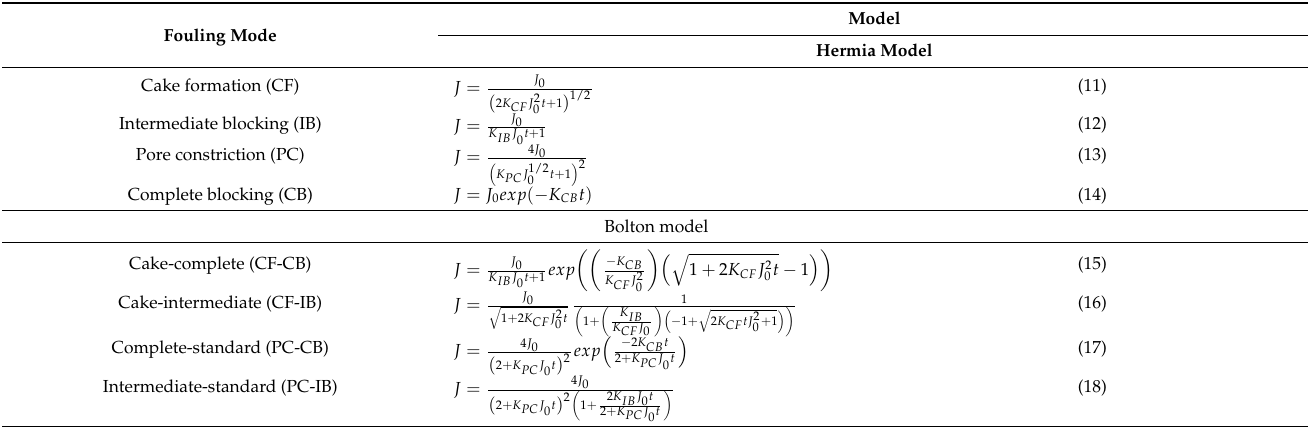
Table 2. Flux expressions of Hermia and Bolton